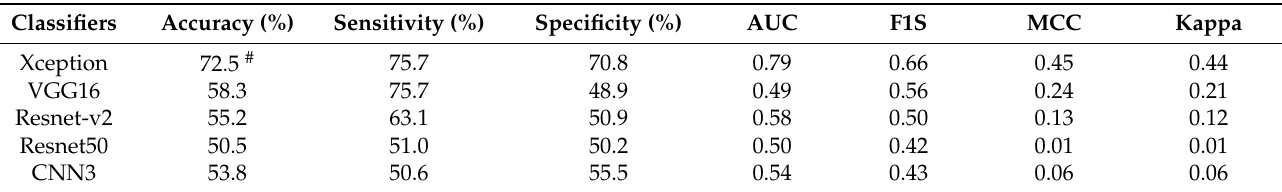
Table 2. Classification performance for mammogram data.